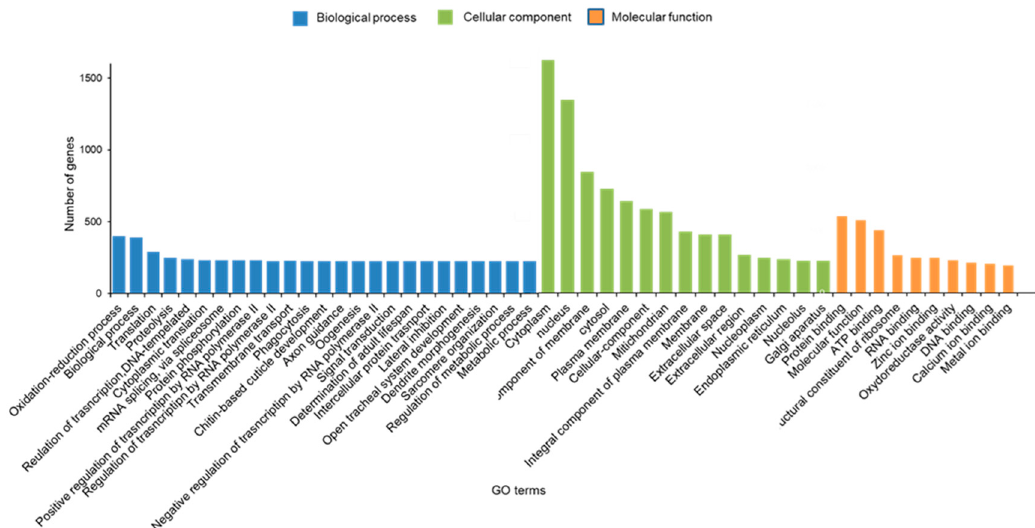
Figure 3. Gene Ontology (GO) enriched terms of differentially expressed genes (DEGs) of Spodoptera frugiperda larvae after exposure to a Noposion Yihaogong ® 5% EC (TR) versus the control group (unselected). The x -axis lists the sub-GO terms under categories of biological process, cellular component and molecular function. The y -axis is the number of DEGs involved in each term.